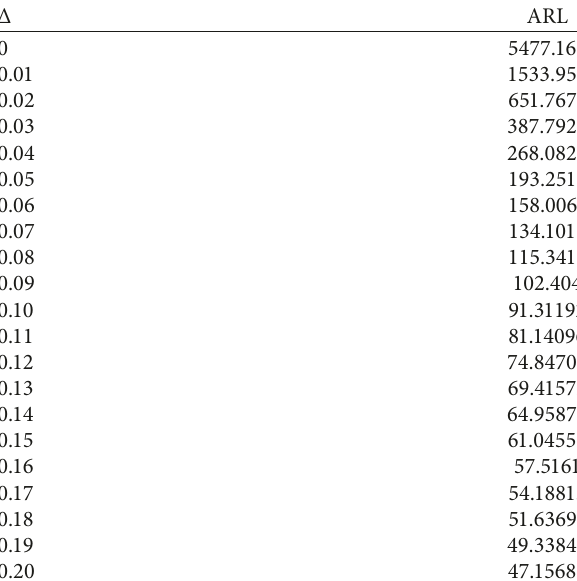
� 2, ϕ � 2, and h � 5 . 1